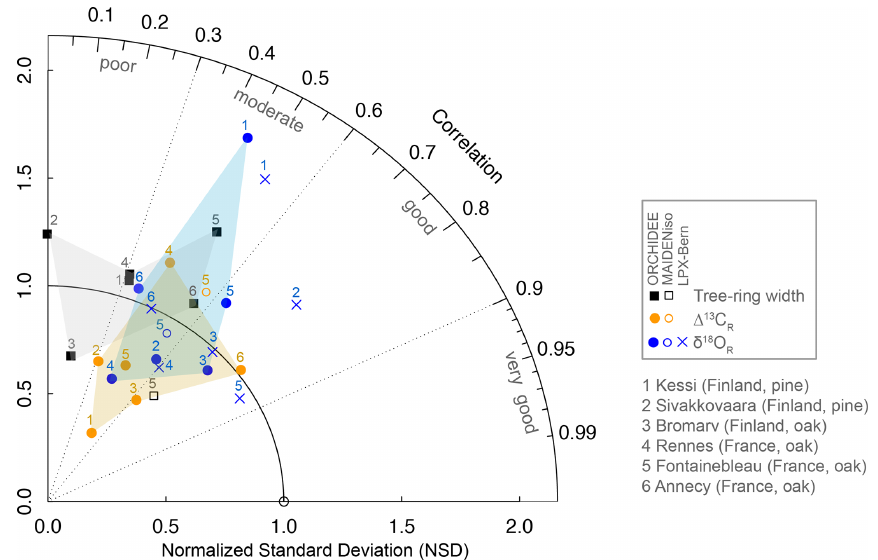
Figure 2. Taylor diagram showing the correlation (angular coordinate) and normalized standard deviation (NSD; radial coordinate) of the simulated tree-ring parameters (ORCHIDEE, MAIDENiso, and LPX-Bern) with respect to the observations for the six sites used in this study (see Table 1). Tree-ring width is denoted by square symbols and (cid:49) 13 C R and δ 18 O R by orange and blue circles, respectively. The models are denoted by solid symbols (ORCHIDEE), open symbols (MAIDENiso in Fontainebleau or site 5), and blue crosses (LPX-Bern). The statistics were computed over the common period 1960–2000, except in Annecy (site 6) where data availability limited the comparison to the period 1971–2000. The target point (NSD and correlation equal to 1) is represented by a circle. The gray, blue, and orange shading denotes the range of the performance statistics covered by ORCHIDEE for tree-ring width, (cid:49) 13 C R , and δ 18 O R , respectively. Four qualitative areas of performance in terms of the magnitude of correlations or simulated variance are indicated as a visual